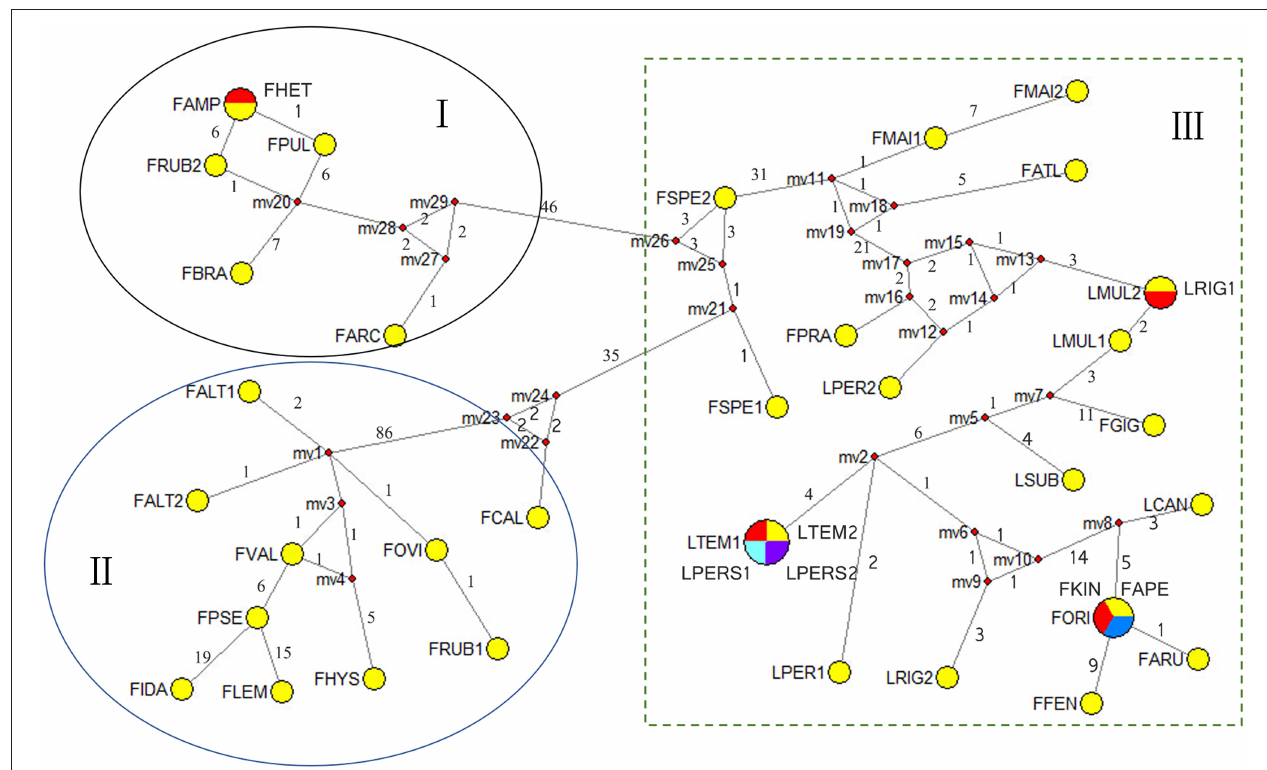
FIGURE 4 | Median-joining networks of the combined data of the Festuca / Lolium examplers. Haplotypes are represented by circles. Numbers along branches indicate number of mutational changes between nodes. Abbreviations of species names are listed in Table 1